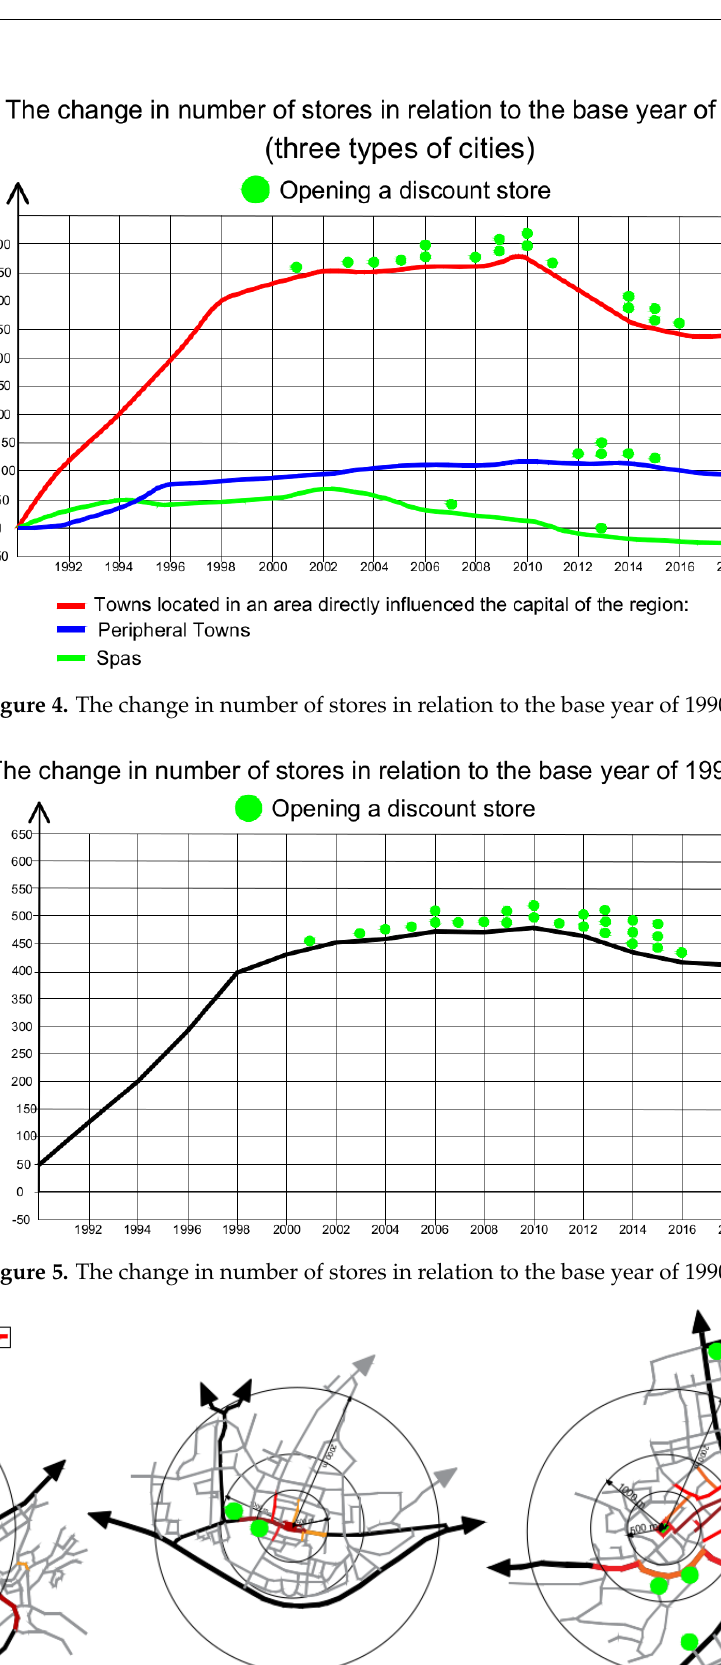
Figure 6. Commercial streets in small towns, 1—market square; 2—discount shop; 3–5—streets with the highest level of commercial activity.